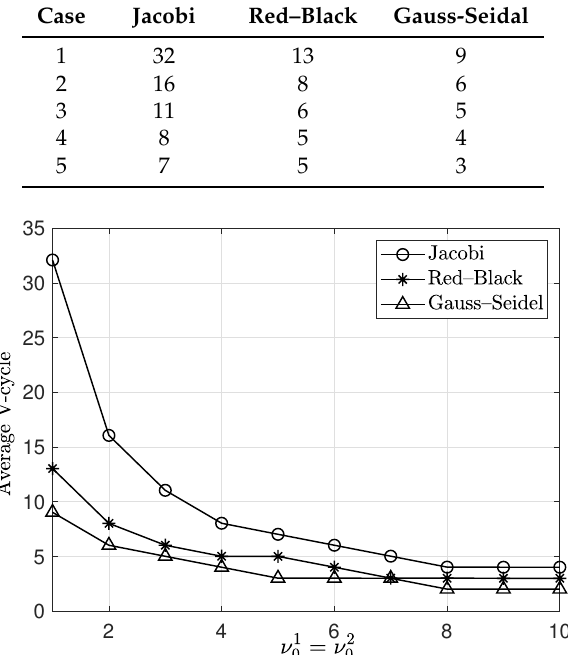
Figure 12. Plot of the average numbers of V-cycles versus ν 1 = ν 2 with the Jacobi ( and Gauss–Seidel (